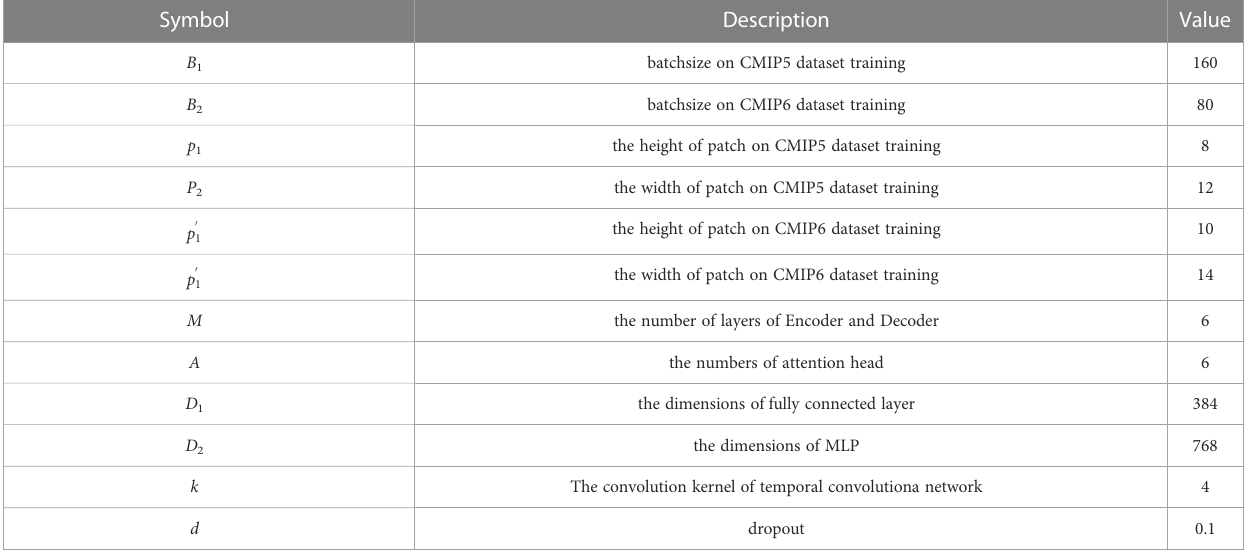
TABLE 4 The hyperparameter symbols, descriptions and values in this study.